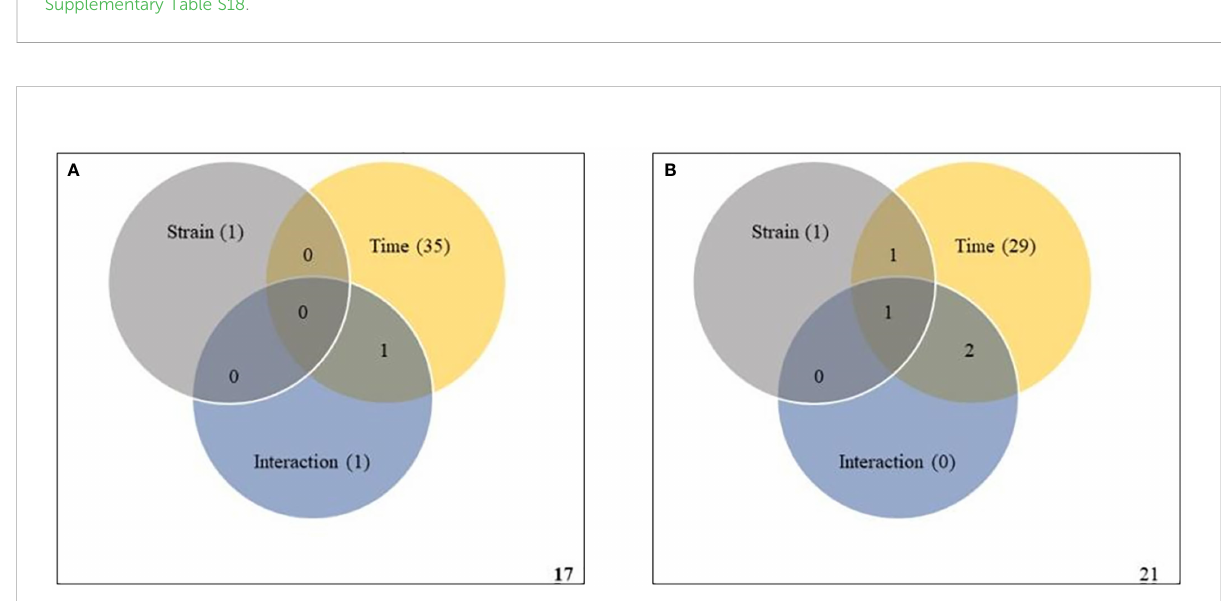
FIGURE 6 Two-way repeated measures (within subjects) analysis of variance (ANOVA) of metabolites affected by potato virus Y (PVY) strain, time and their interaction during local and systemic infection of Premier Russet (A) and Russet Burbank (B) . Grey, yellow, and blue circles respect strain, time, and their interaction, respectively. Figures in the circles represent the kinds of metabolites that responded to each